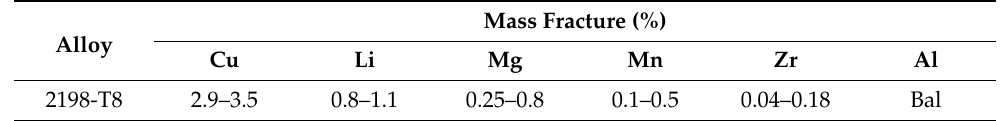
Table 1. Chemical compositions of base material.